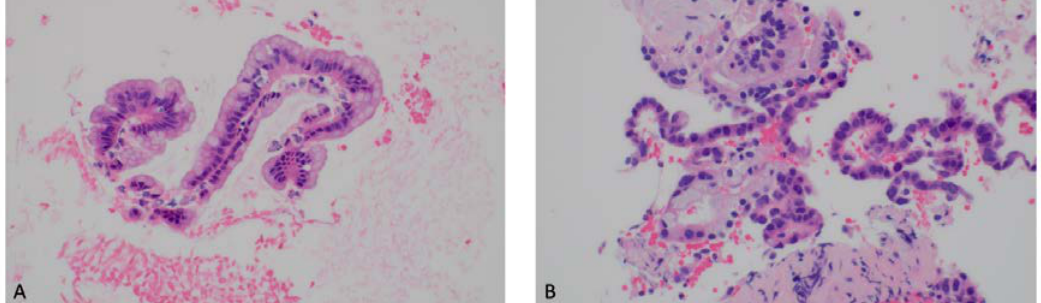
Figure 4. Intraductal papillary mucinous neoplasm (IPMN) histopathology (courtesy of Dr. Michael G. Ozawa, Stanford University). ( A ) Low-grade IPMN showing epithelial atypia. ( B ) High-grade IPMN showing severe epithelial atypia with necrotic debris. Hematoxylin and eosin stain, 100 × magnification